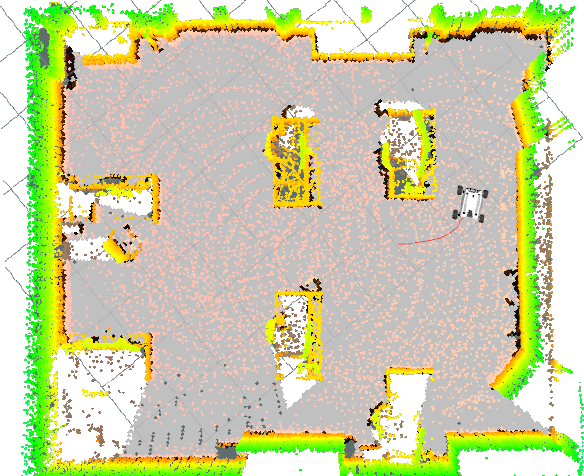
Figure 2. Occupancy grid and three dimensional map built by LeGO-LOAM. The current local path for exploration is displayed as a red line.